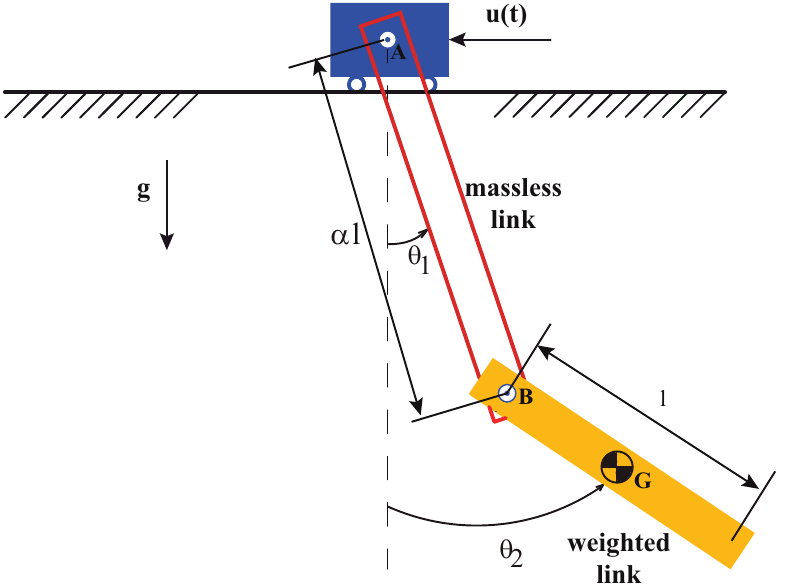
Figure 13. Planar double pendulum. Conditions: massless first link length α · l equivalence with composite revolute-revolute joint and the weighted second link with mass m , plus moment of inertia about the mass center I G zz